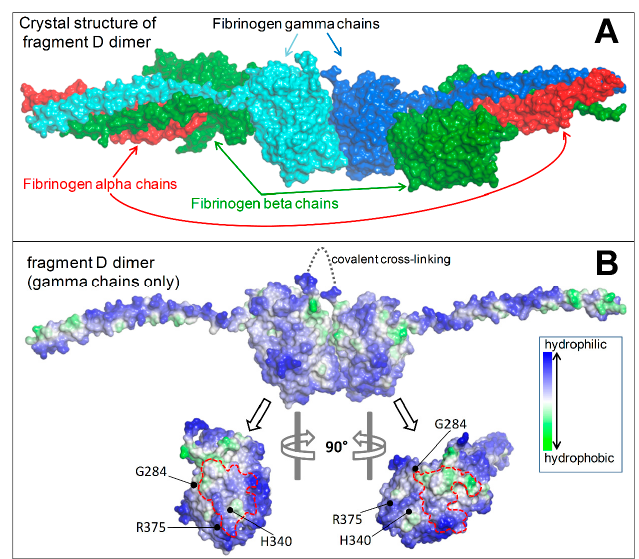
Figure 2. Crystal structure of the covalently bound dimer of fragment D (double-D). ( A ) Molecular surface representation of the fibrinogen chains composing the fragment D dimer (PDB 1FZB); ( B ) The two fibrinogen gamma chains arranged head to head as in the fragment D dimer and after rotations of 90° are shown to highlight the regions of mutual interaction (areas enclosed by the red, dotted lines). Molecular surfaces are colored according to the residue hydrophobicity. The positions of the residues mutated in Fibrinogen Ankara (H340), Aguadilla (R375), and Brescia (G284) are indicated. The covalent link between the gamma chains is schematized by the gray, dotted line.